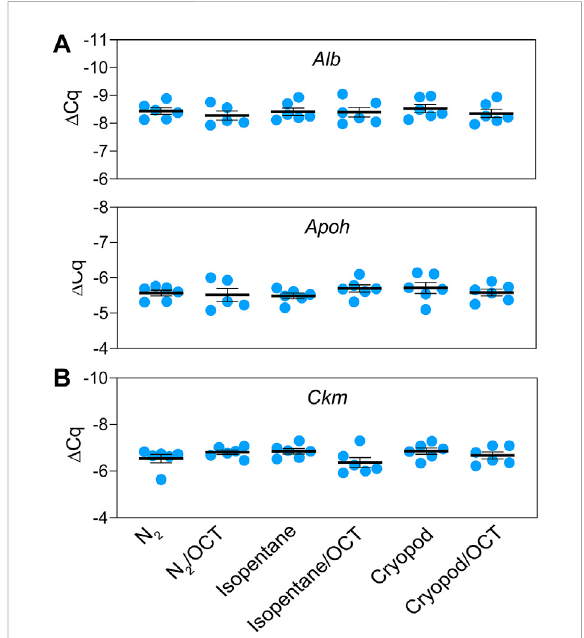
FIGURE 2 Relative mRNA expression levels (mean ± standard error) of the tissue-speci fi c biomarkers: albumin and apolipoprotein H in liver (A) , and creatine kinase in muscle tissue (B)